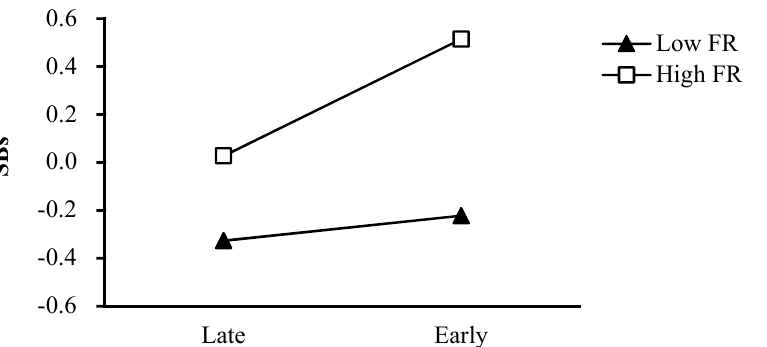
Figure 2. The two − way interaction between PT and FR in predicting girls’ SBs. Note: PT pubertal timing, FR father rejection, SBs smoking behaviors.